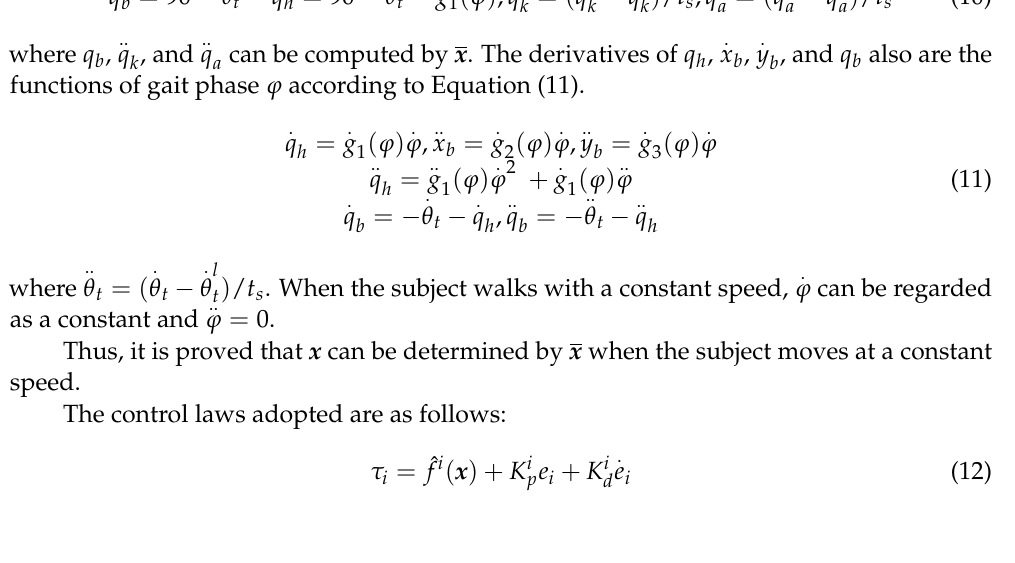
and gait phase. ( c ) Scatter plot b